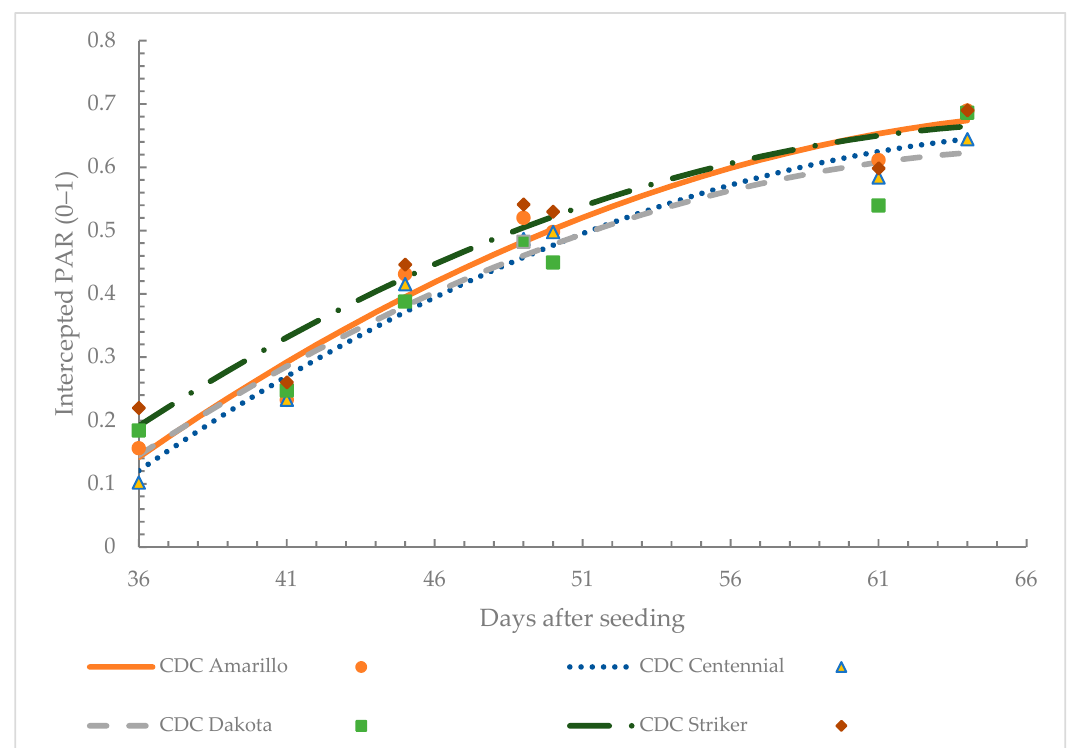
Figure 2. Canopy light interception of four field pea varieties during early vegetation and podding stages. Mean of one site in 2017, two sites in 2018, and two sites in 2019.